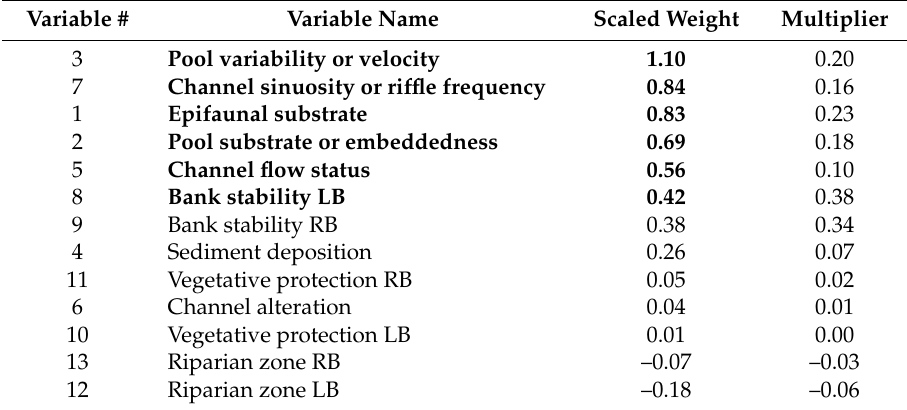
Table 8. RBP Index scaled and un-scaled (multiplier) weights. Variables with larger scaled weights (absolute value ě 0.4) are shown in bold. Scaled weight indicates the relative importance of each variable for prediction of EPT taxa. The multiplier can be used with the field collected data points for each variable to calculate new index scores for each